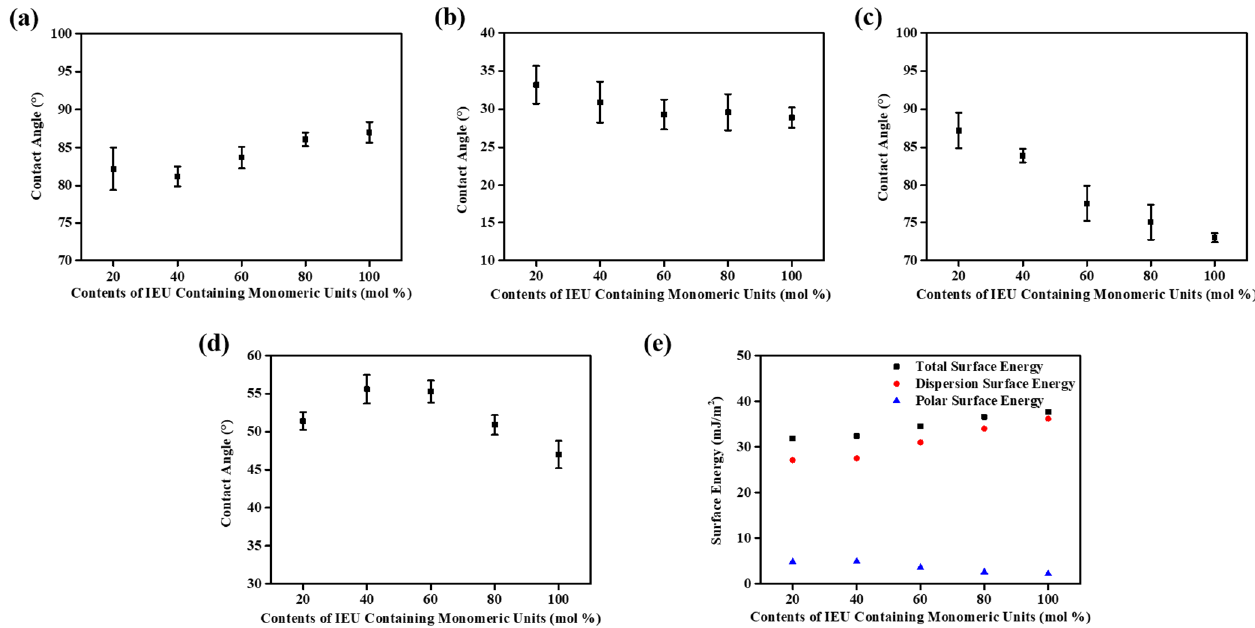
Figure 7. Contact angles of ( a ) water, ( b ) diiodomethane, ( c ) formamide, ( d ) ethylene glycol, and ( e ) surface energy values of PIEU# films according to the molar content of the isoeugenol moiety in the side groups. Table 2. Surface energy values and liquid crystal (LC) alignment properties.